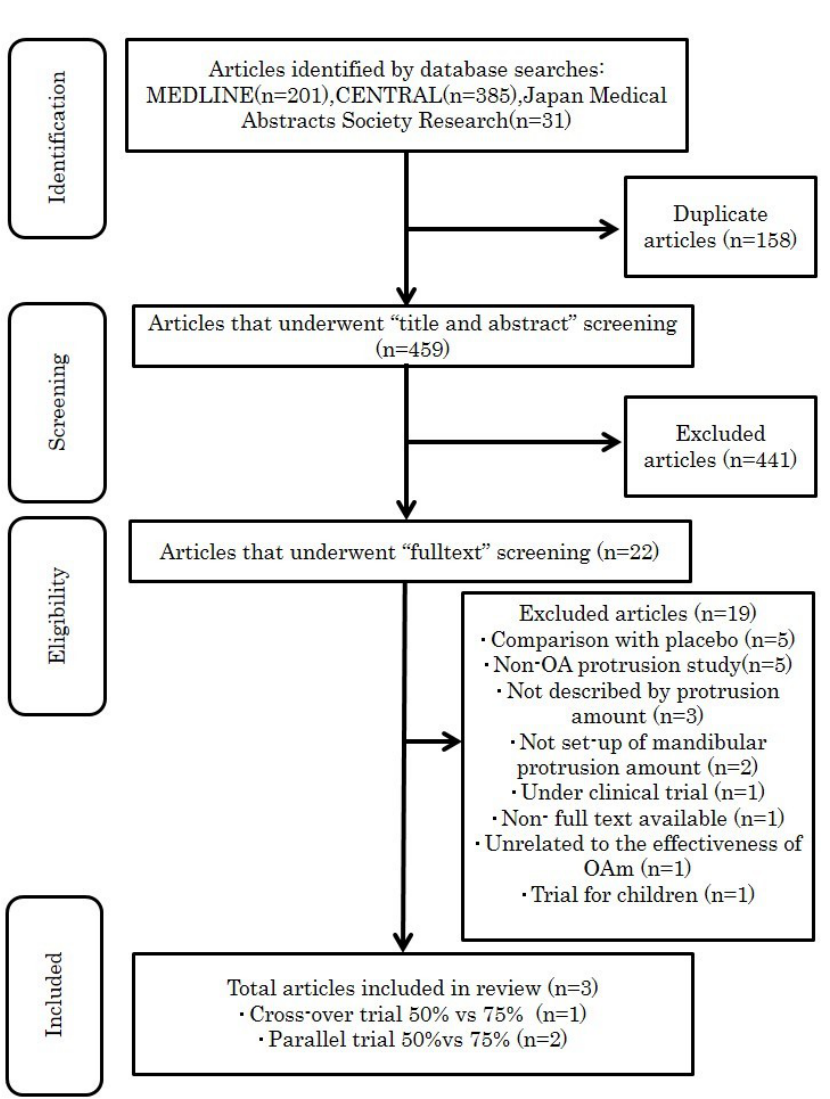
Figure 1. Flow diagram of the literature search.